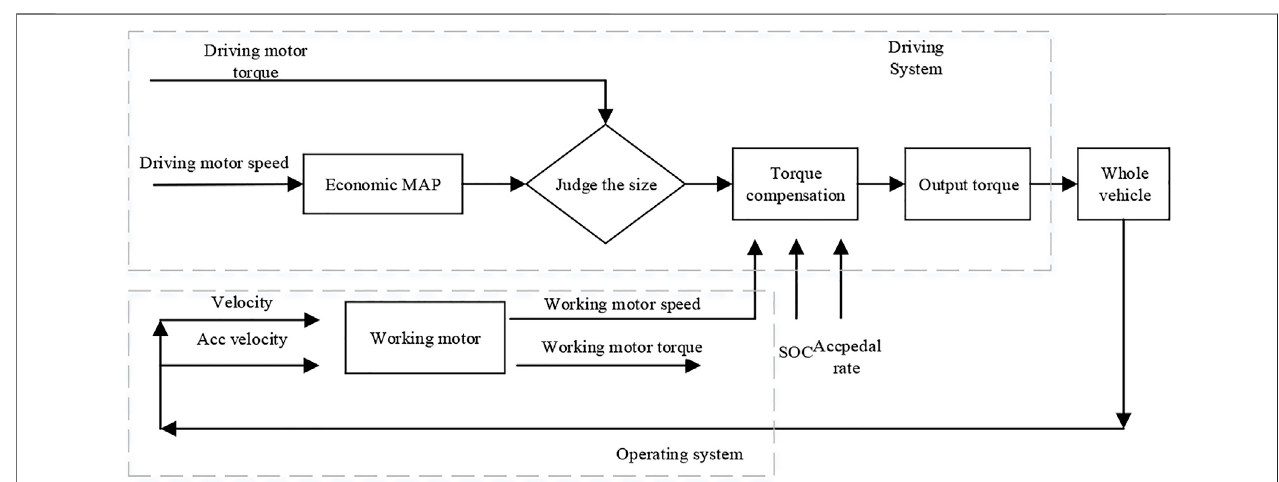
FIGURE 6 | Torque control